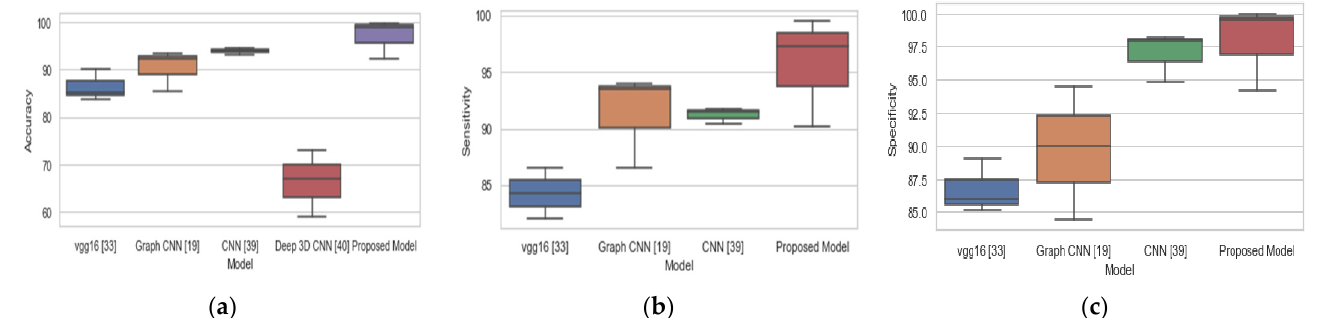
Figure 4. Comparison of proposed method and existing methods for binary classification: ( a ) accuracy, ( b ) sensitivity, ( c ) specificity.